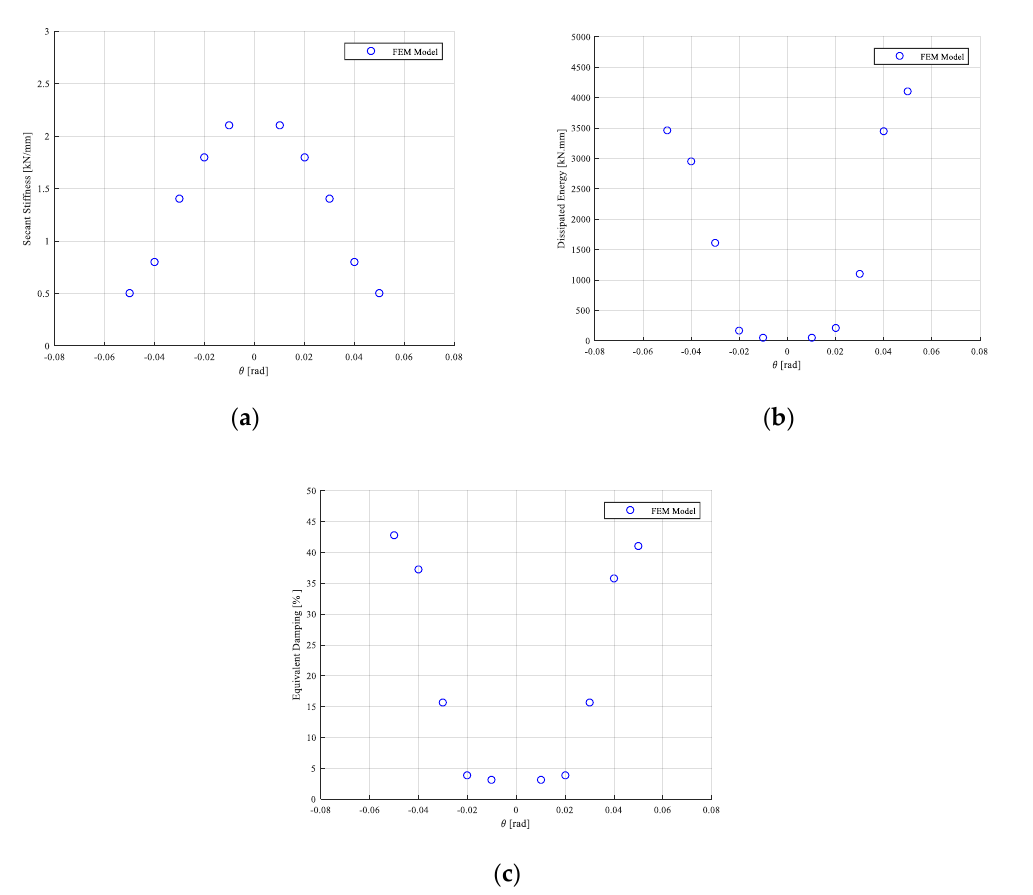
Figure 15. ( a ) Secant stiffness vs. rotation curve, ( b ) dissipated energy vs. rotation curve, ( c ) equivalent damping vs. rotation in numerical model.